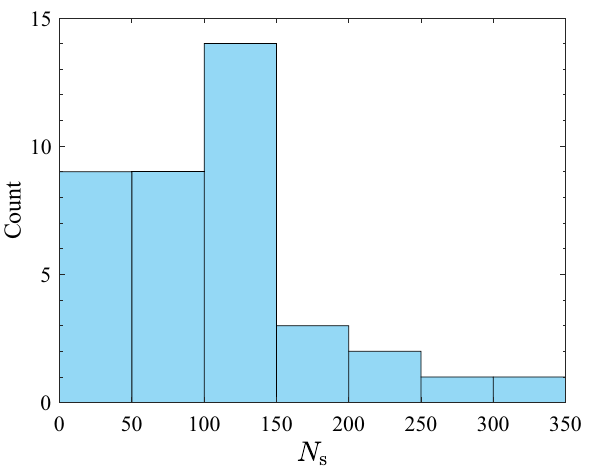
Figure 16. Frequency distribution of N s